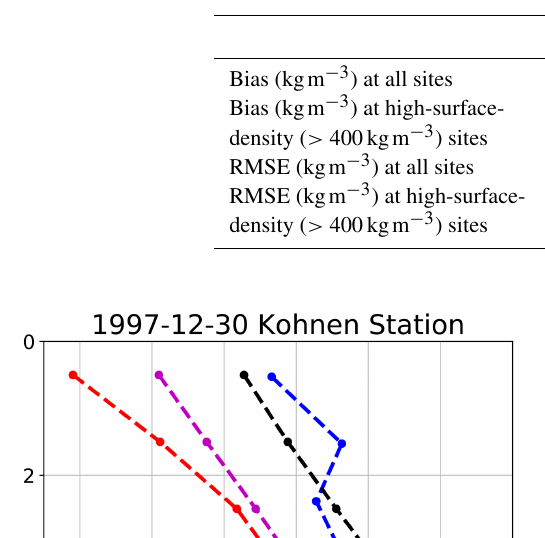
Table 1. SNOWPACK-, GSFC-FDM-, and IMAU-FDM-simulated mean surface density bias and RMSE at all 79 sites and at sites whose observed surface density exceeds 400kgm − 3 .